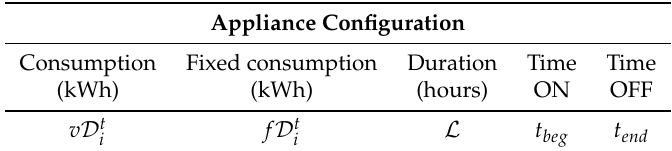
Table 1. Appliance